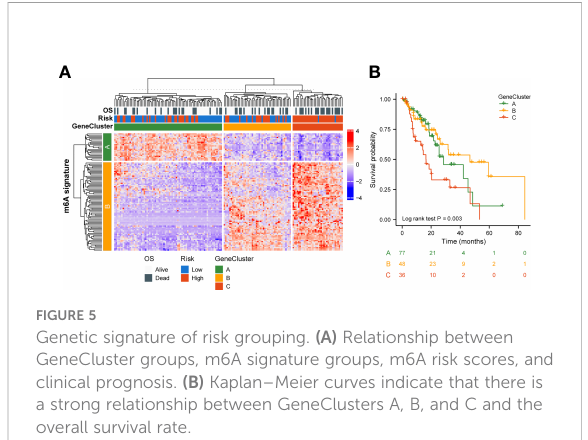
FIGURE 6 Molecular pro fi ling of high and low m6A score groups. (A) Distribution of driving genes during common tumorigenesis between high and low m6A score samples; (B, C) Tumor mutation burden distribution in the different m6A score samples and GeneCluster groups; (D) Distribution of copy number ampli fi cations and deletions in high and low m6A score samples.